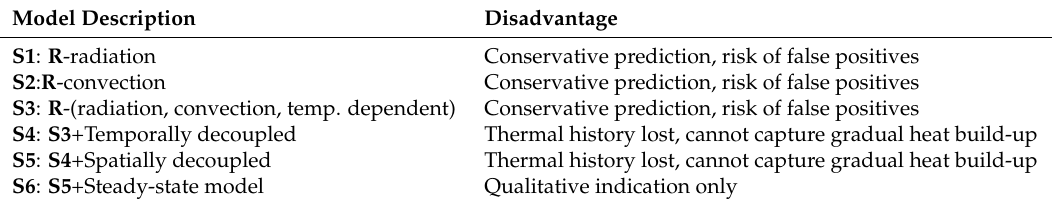
Table 3. A summary of disadvantages associated with each